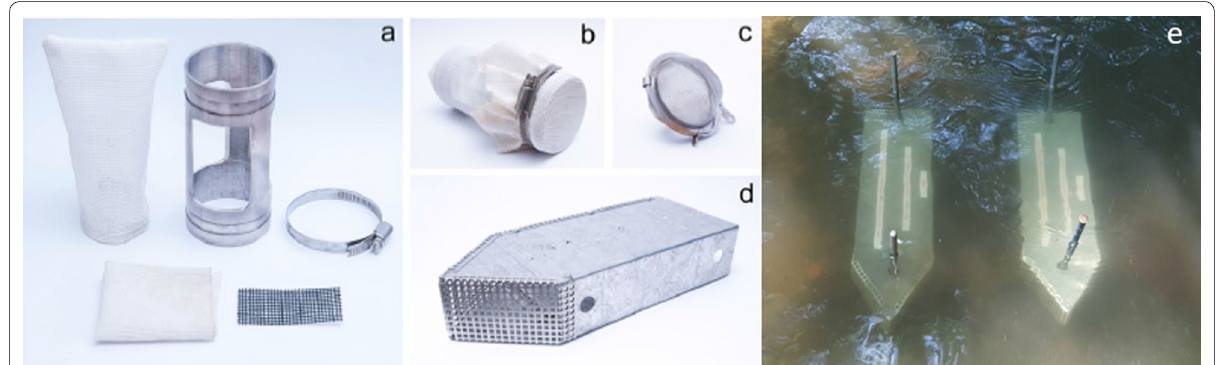
Fig. 1 Setup of the active biomonitoring campaigns with Potamopyrgus antipodarum and Gammarus fossarum. a Composition of enclosure for gammarids, b stainless steel enclosure for the exposure of G. fossarum , c stainless steel tea–egg for the exposure of P. antipodarum, d cage for the attachment onto the river bed, e exposed cages [Photo: Moritz